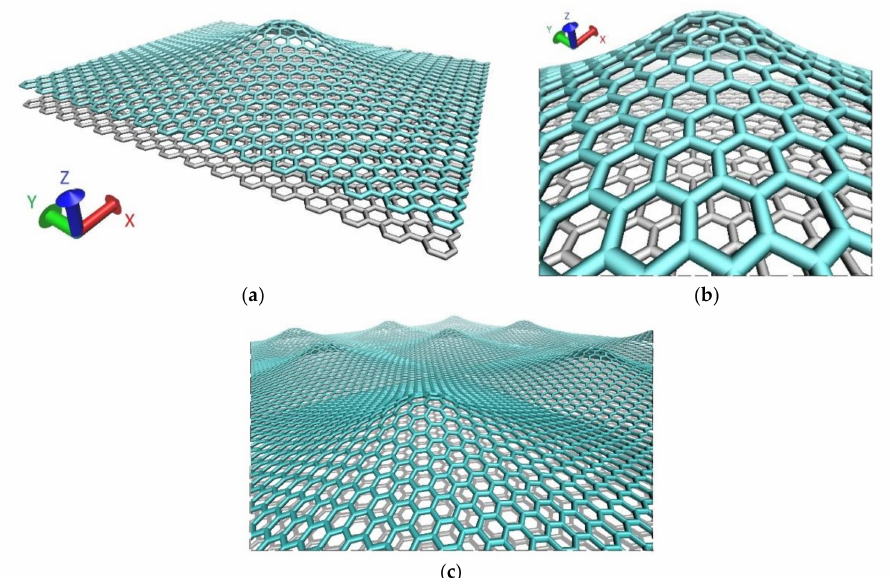
Figure 1. Atomic model of graphene nanoblister: ( a ) super-cell; ( b ) the tip of the nanoblister; ( c ) the overview of the nanoblister surface (the substrate is noted by silver color, the monolayer with graphene nanoblisters is noted by blue